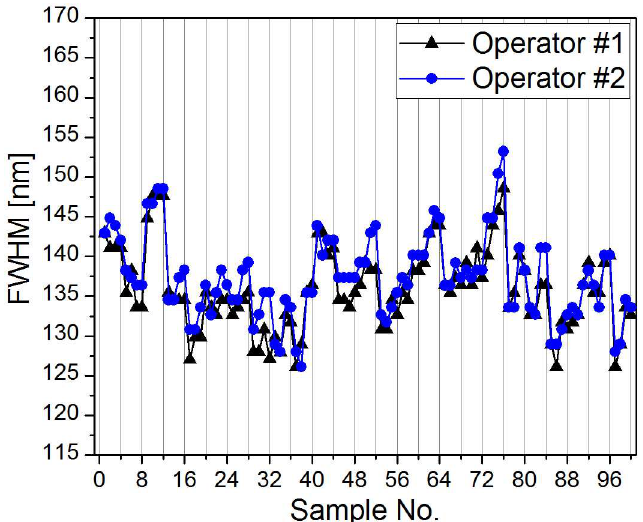
Fig 8. Full width at half maximum results of the main reflectancepeak in the two independent measurements of Polyommatus icarus males. The high reproducibility of integratingspherelight collection is clearly observed(n = 100